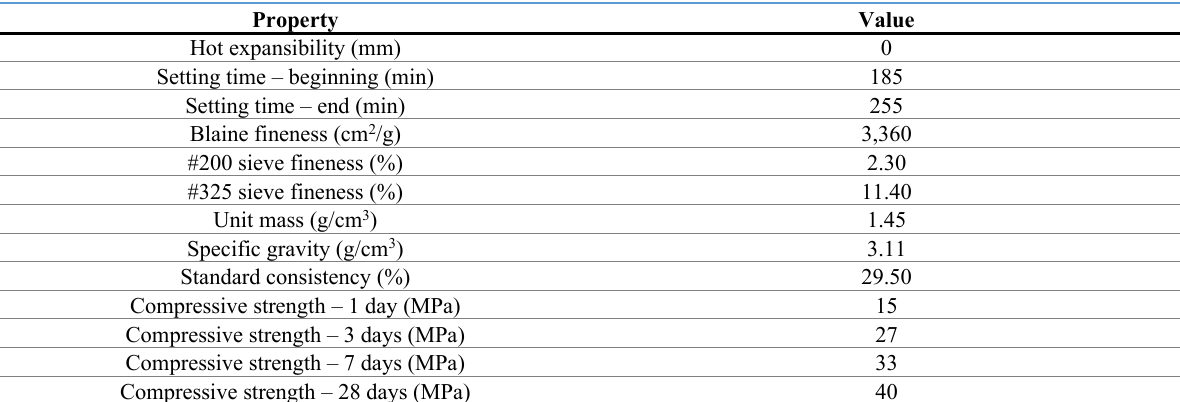
Table 3. Physical characterization of cement